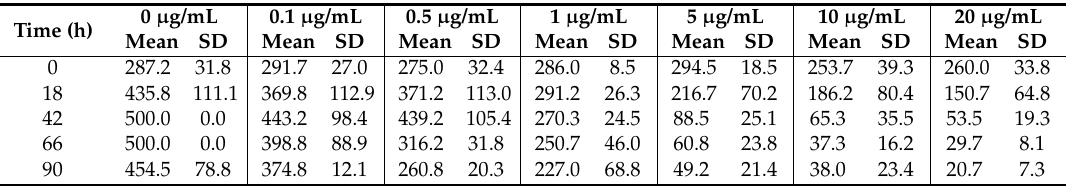
Figure 8. Growth kinetics of M. avium with gentamicin treatment over 90 h at ( A ) 10 − 6 dilutions. Differences between the slopes of each treatment are significant at p < 0.01 according to linear regression analysis. Average values are reported without error bars for graph clarity. ( B ) 10 − 7 dilutions. Differences between the slopes of each treatment are significant at p < 0.0001 according to linear regression analysis, n = 3. Table 2. Mean and standard deviation of bacterial growth (CFU) at 10 6 dilutions for M. avium with gentamicin treatment over 90 h, n =